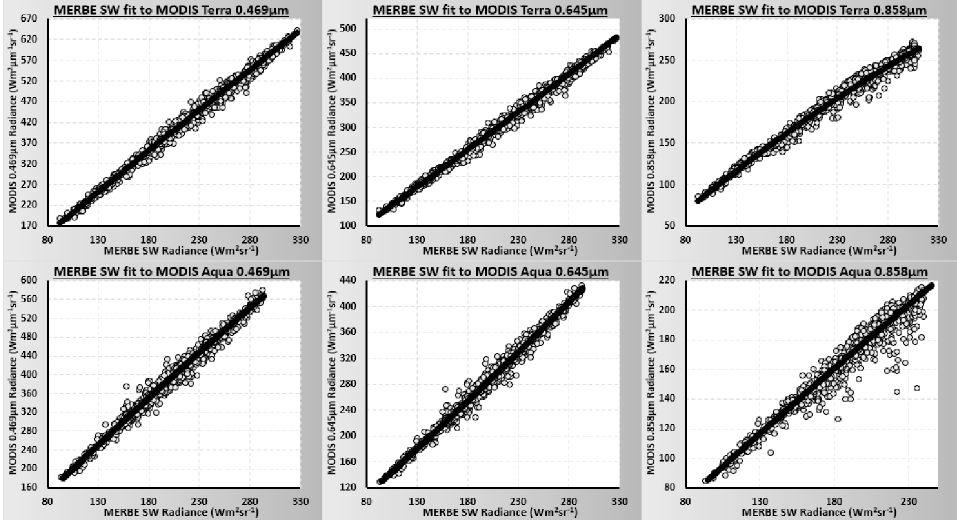
Figure 2. Quadratic regressions of MERBE SW data with MODIS Terra and Aqua Channels 1–3.